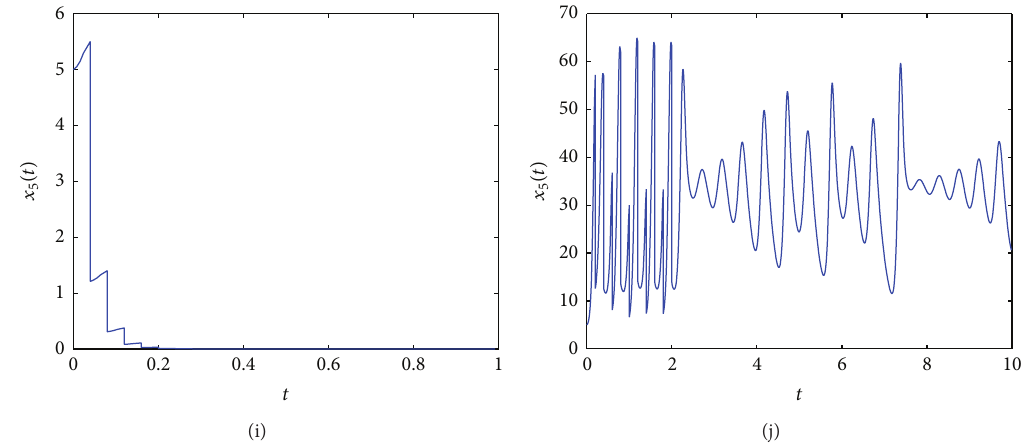
Figure 2: Left figures: Impulsively control complex Lorenz system with 𝜏 = 0.01 , Right figures: Impulsively control complex Lorenz system cannot be stabilized with 𝜏 = 0.2